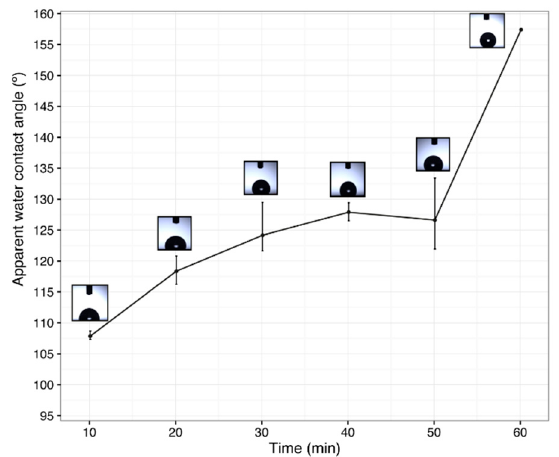
Figure 6. Apparent water contact angle of the multilayer film based on low-density polyethylene (LDPE), poly( ε -caprolactone) (PCL) fibers, and silica (SiO 2 ) microparticles for different electrospraying deposition times (10, 20, 30, 40, 50, and 60 min) of SiO 2 . The profiles of the water droplets are included as insets for each time point. The electrospun PCL deposition time was 2 h, and the thermal treatment was carried out at 55 °C for 1 min.